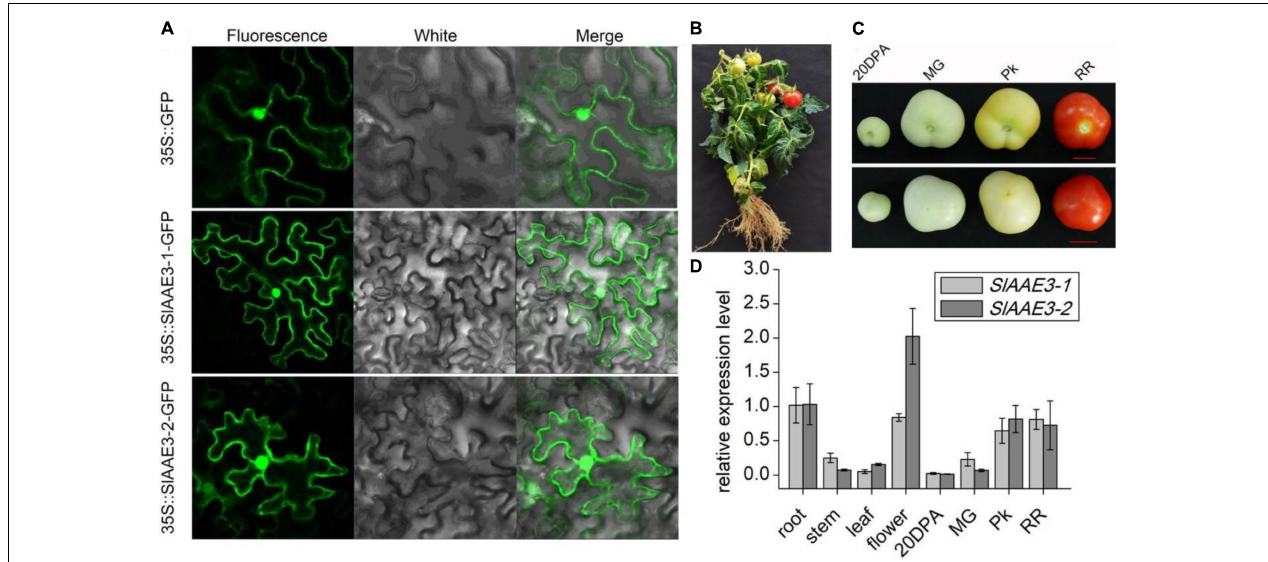
FIGURE 2 | Subcellular localization and histological expression pattern of SlAAE3-1 and SlAAE3-2. (A) Confocal image of Nicotiana benthamiana cells expressing AAE3-1-eGFP or SlAAE3-2-eGFP. Bar: 50 µ M. eGFP driven by 35S promoter was used as control. (B) Plant stature at reproductive stage. (C) Fruits at different development stages. 20 DPA, 20 days post-anthesis; MG, mature green; Pk, pink stage; RR, red ripe. Bar = 1 cm. Upper panel: bottom-up view of fruits. Lower panel: top view of fruits. (D) Relative expression of SlAAE3-1 and SlAAE3-2 in different organs of tomato plants. For different developmental stages of fruits, the materials were collected at corresponding stages shown in panel (C) . Plant materials were immediately frozen in liquid nitrogen for RNA extraction. Actin (Solyc02g063070.2.1) was used as an internal control. Data are means ± SD ( n = 3).